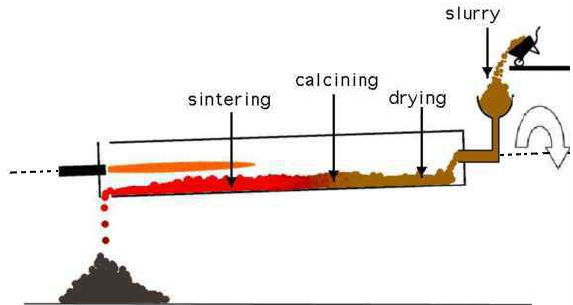
Figure 1. Schematic of the rotary kiln [2]. Reproduced with permission from WHD Microanalysis Consultants